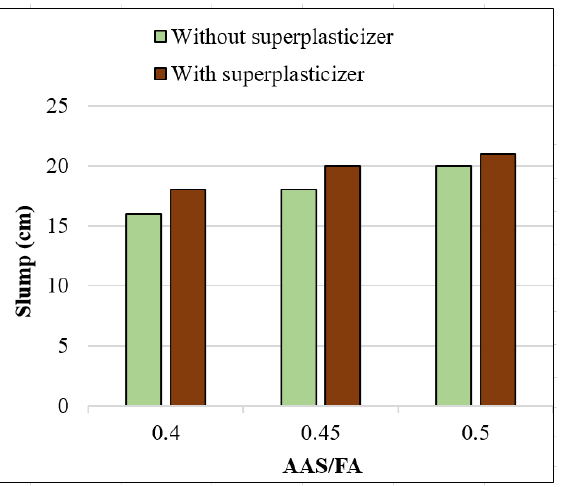
Figure 8. Slump values of GRAC in function of alkaline activated solution/fly ash AAS/FA ratios .